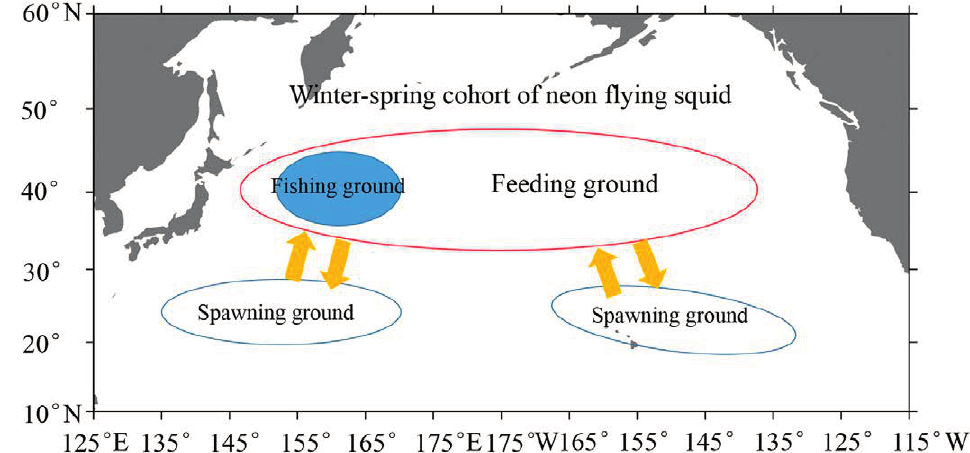
Fig. 1. – The migration pattern and traditional fishing ground of the winter-spring cohort of Ommastrephes bartramii in the North Pacific